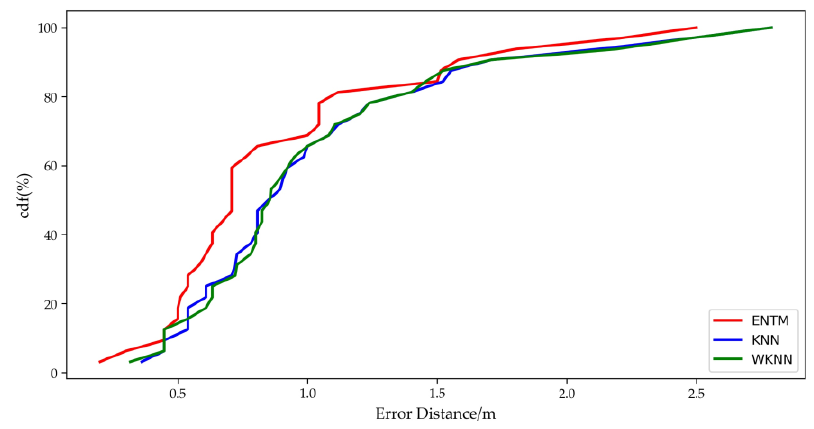
Figure 12. Comparison of locating error with three algorithms in terms of CDF (Cumulative Distribution